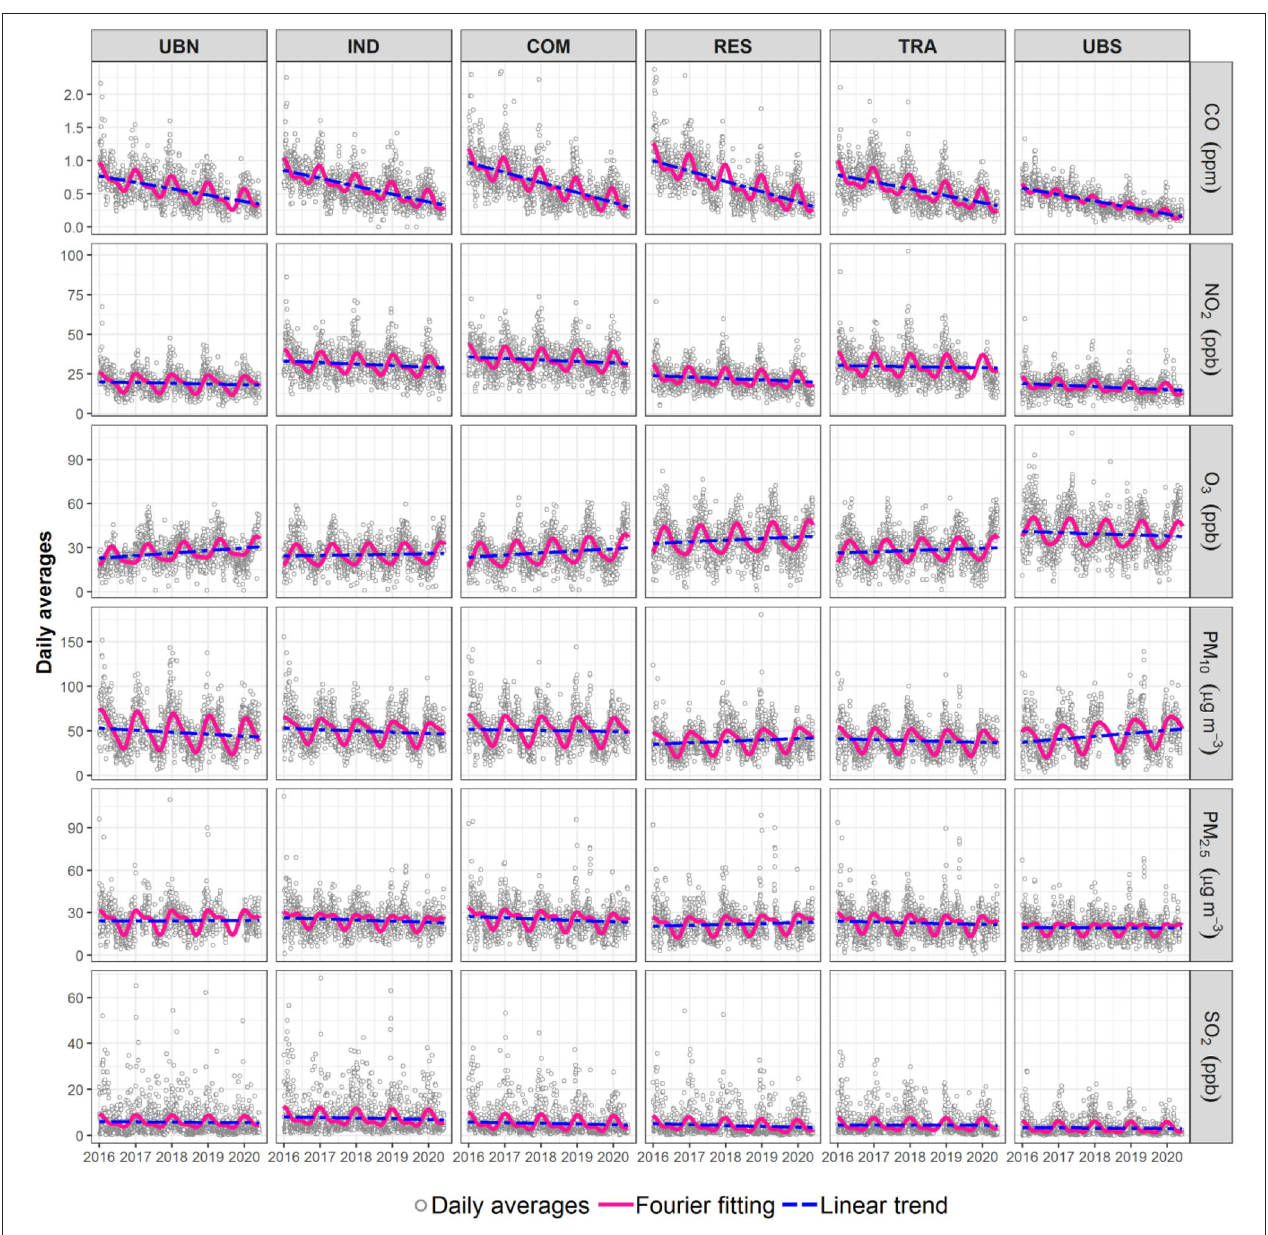
FIGURE 1 | Time-series of criteria air pollutants from 2016 to 2020 at the six selected monitoring sites within the MCMA. The continuous lines show the Fourier fitting and modelled linear